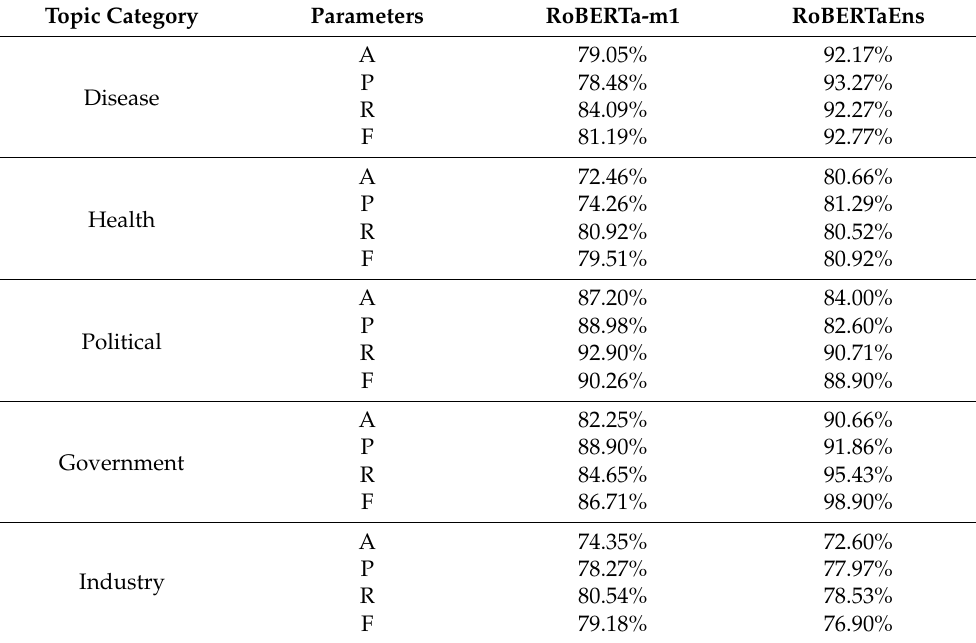
Table 4. Comparison of RoBERTa-m1 and RoBERTaEns by the News Topic Category.